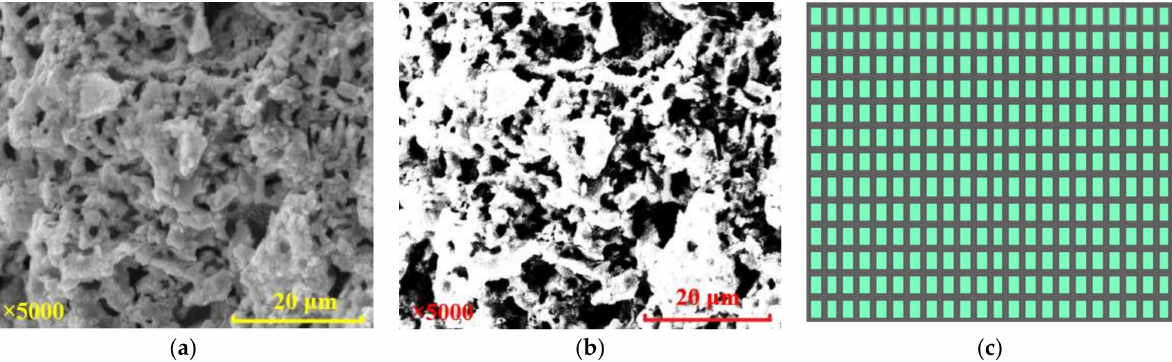
Figure 13. Binary analysis of a microscopic image of paste with pumping agent and the extraction process of the force chain: ( a ) SEM image at a magnification of 5000; ( b ) binary image; ( c ) idealized sketch of force